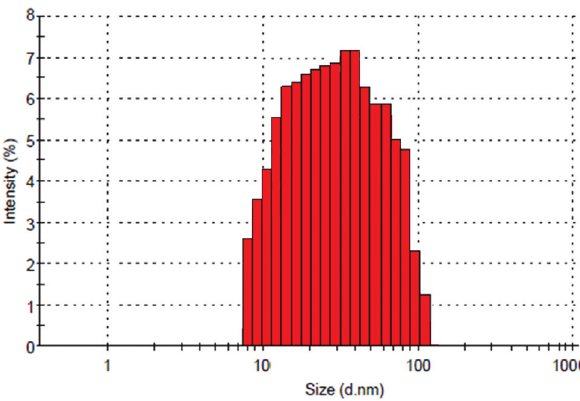
Figure 7: DLS of Fe